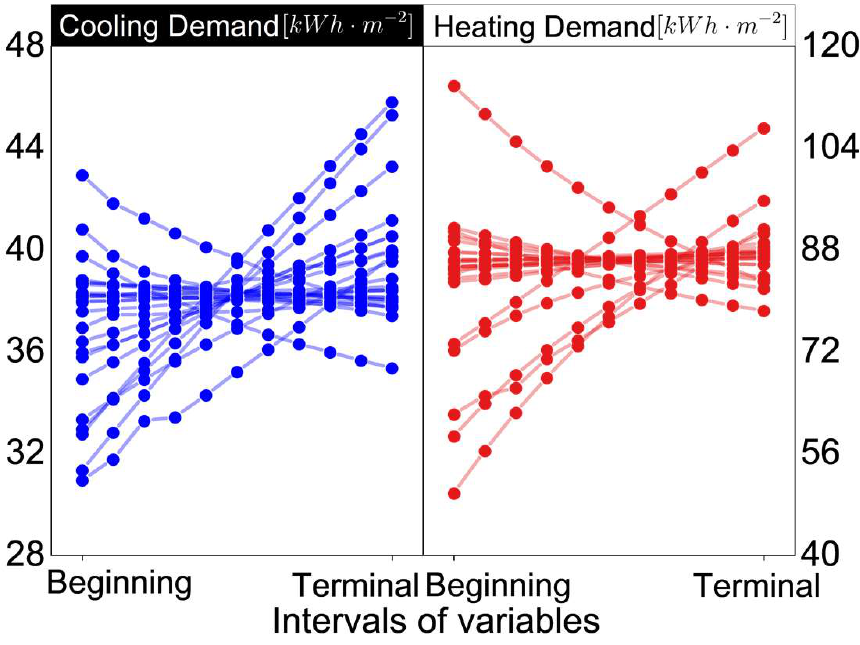
Figure 4. Fluctuation trend of energy demand with 25 variables.